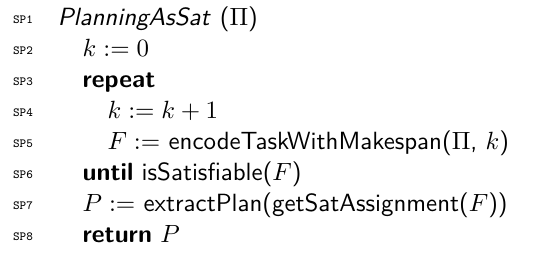
Figure 1. Pseudo-code of the basic planning as satis- fiability